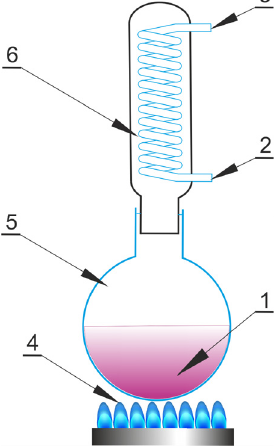
Figure 14. Scheme of the apparatus for carrying out the syntheses connected with the transformations of geraniol: 1—reaction mixture; 2—water outlet; 3—water inlet; 4—heating; 5—round bottom flask; 6—reflux condenser.